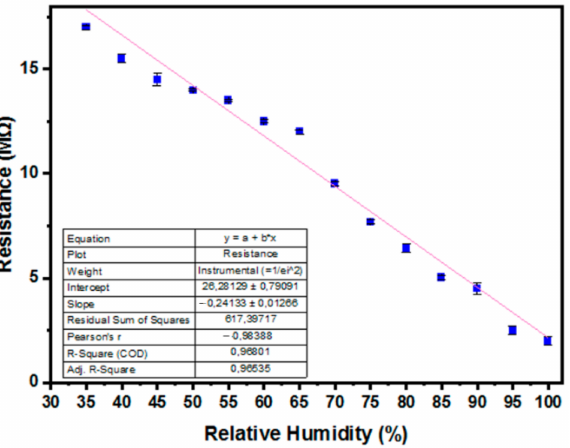
Figure 5. Graph of the resistance change of the sensor against relative humidity.